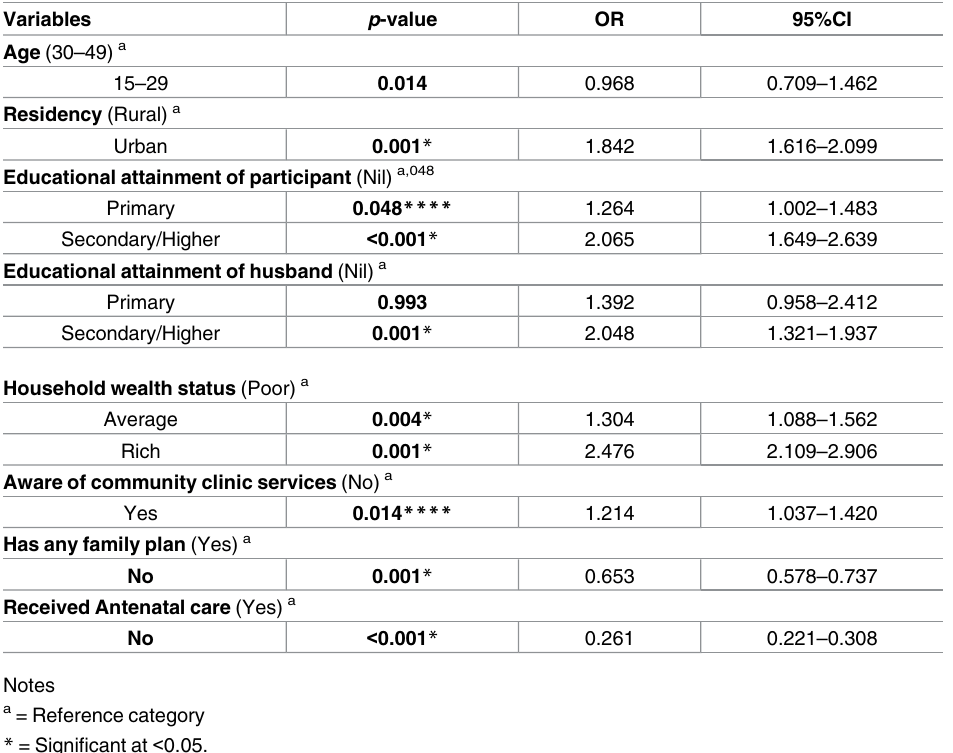
Table 3. Predictors of institutional delivery serviceutilization among Bangladeshi women, BDHS